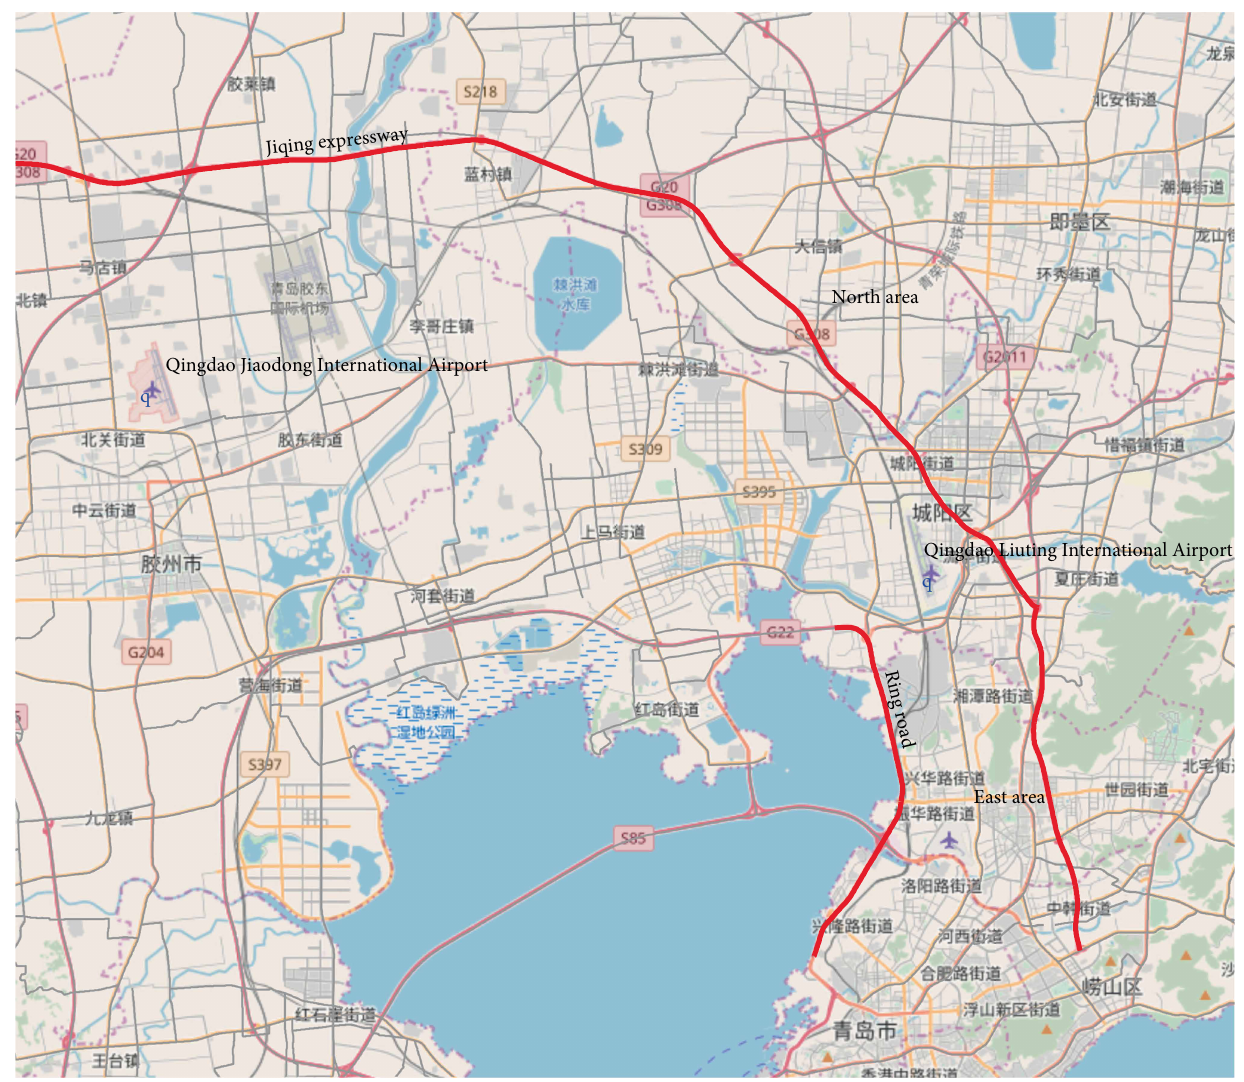
Figure 8: Jiqing expressway, ring road and